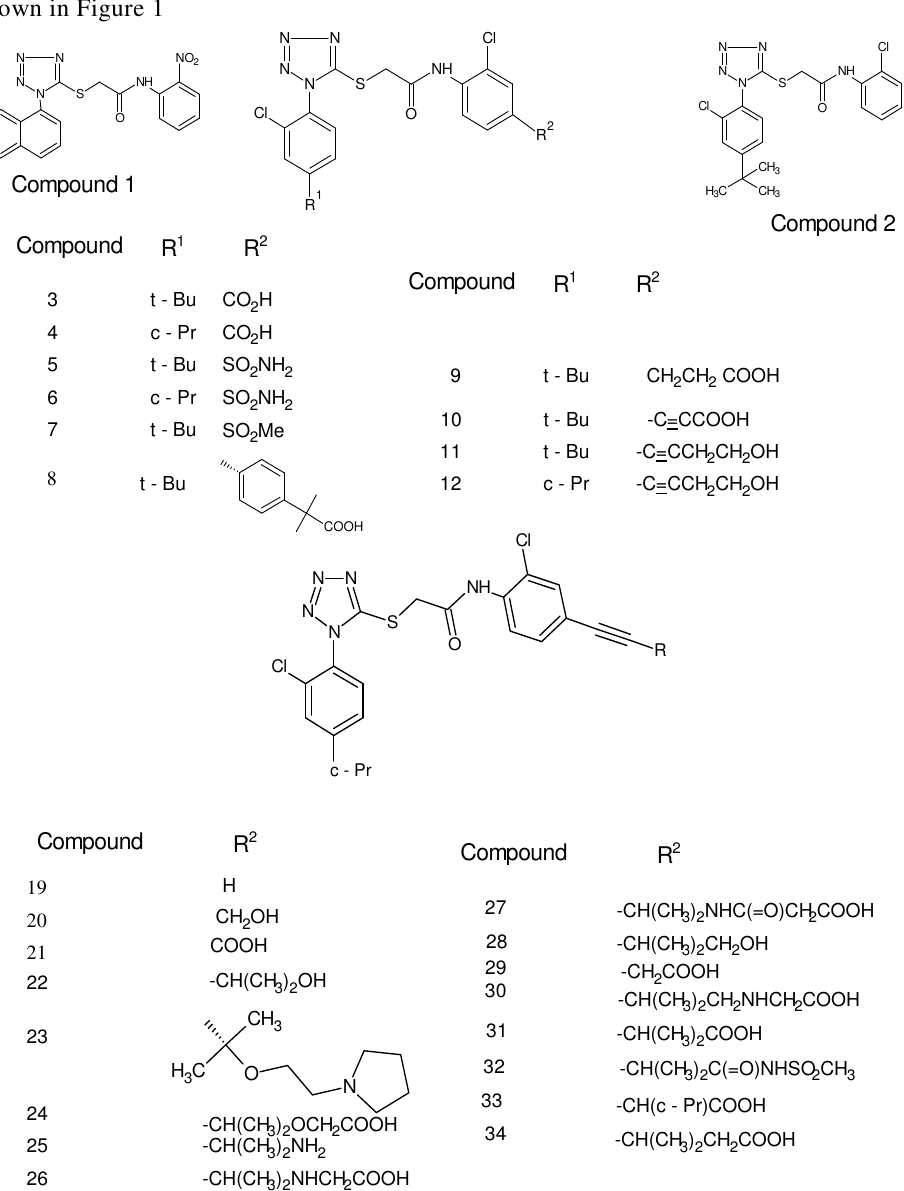
Figure 1. Structure of thiotetrazole